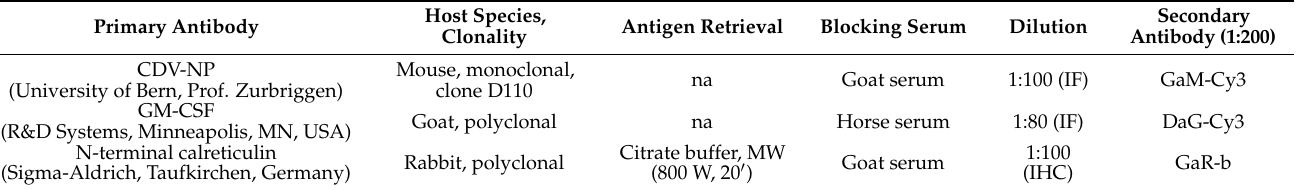
Table 7. Summary of antibodies used for immunostaining including primary antibodies, host species, clonality, blocking serum, dilution and secondary